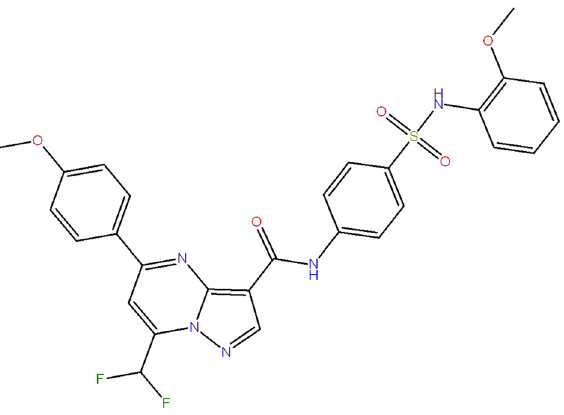
Figure 1. Structure of I194496. I194496 was known as 7-(difluoromethyl)-N-{4-[(2-methoxyanilino) sulfonyl] phenyl}-5-(4-methoxyphenyl)pyrazolo[1,5